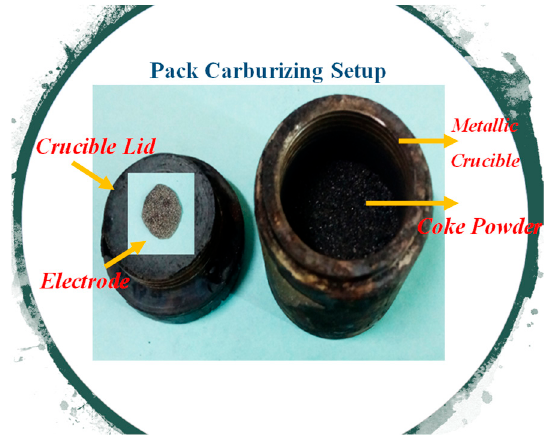
Figure 1. Sealed metal crucible for pack carburizing and Ni foam to be coated.